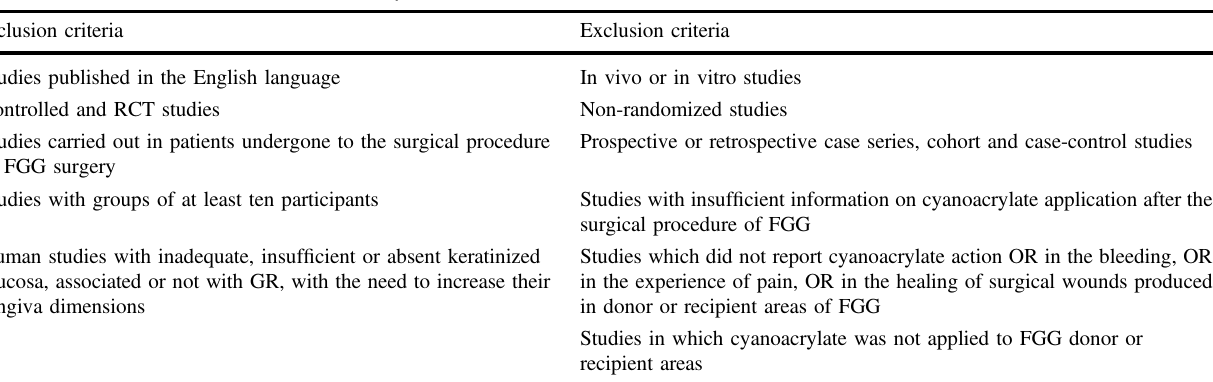
Table 1 Inclusion/exclusion criteria for this